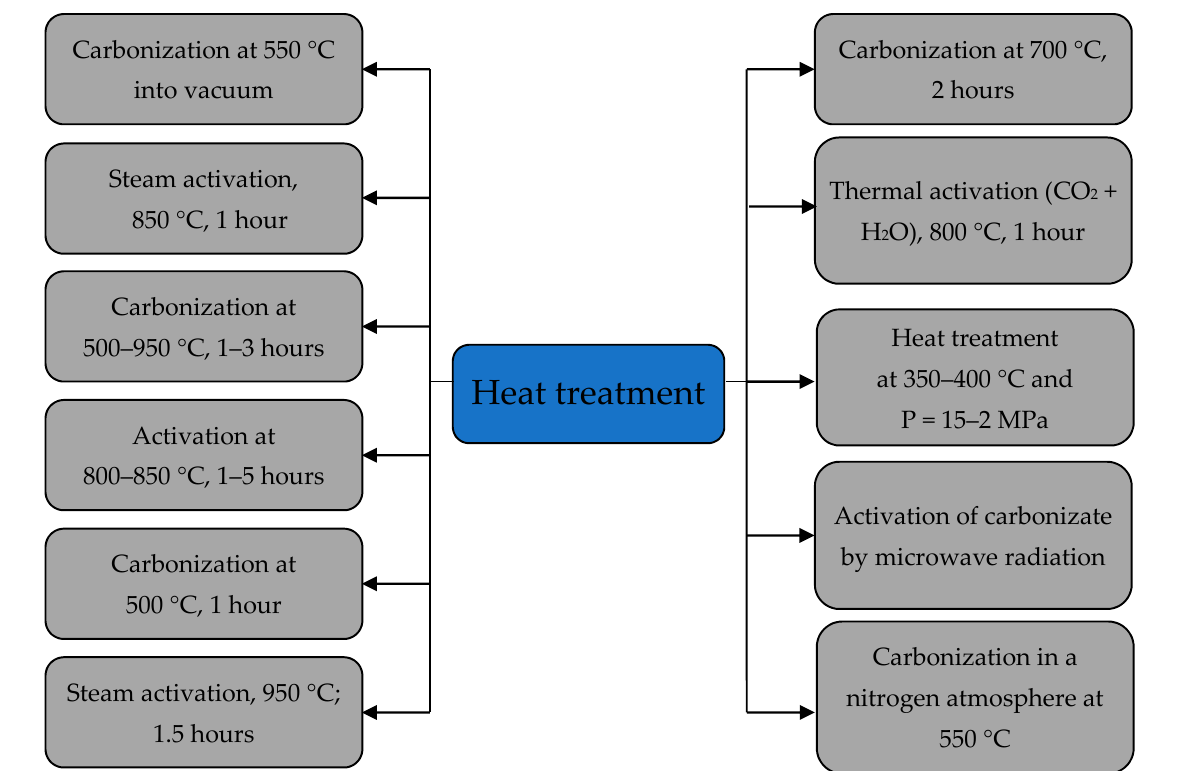
Figure 9. Some methods of heat treatment of apricot kernel shells.